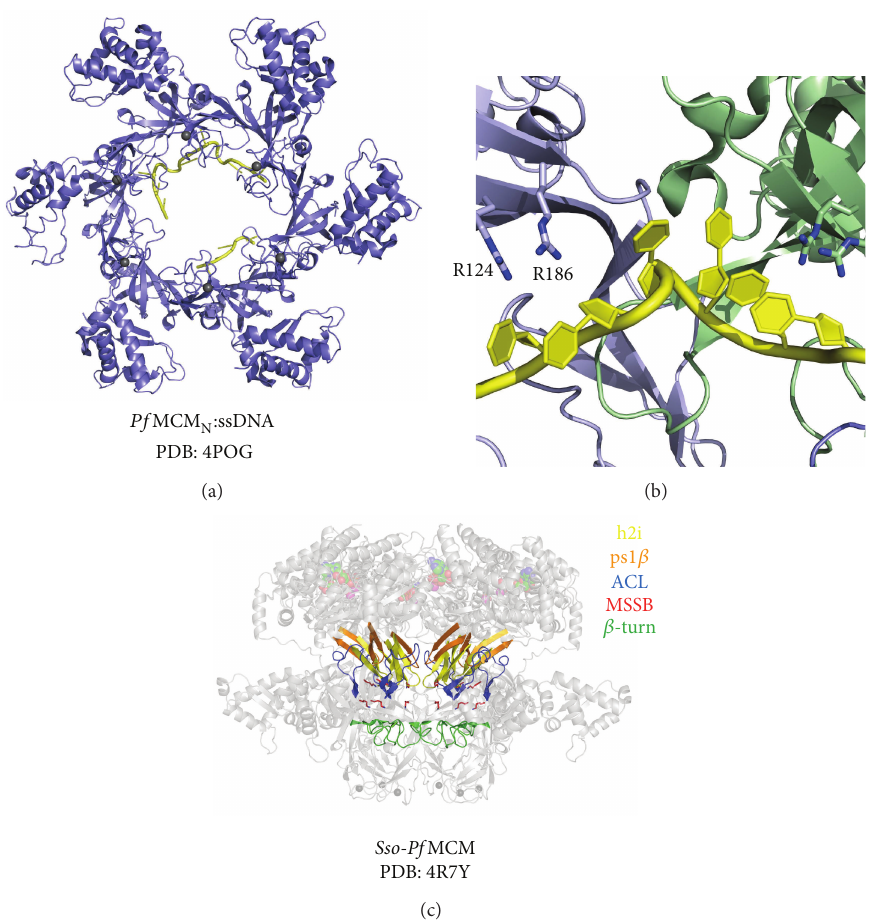
Figure 6: Features of DNA binding in MCM hexamers. (a) The cocrystal structure of 𝑃𝑓 MCM in the plane of the hexamer. The DNA binds with a 3 󸀠 to 5 󸀠 polarity in the clockwise direction around the ring when viewed from the N- terminal side of the hexamer. DNA is shown in yellow and zinc ions are shown as grey spheres. (b) DNA binds across subunit interfaces through interactions between the DNA and MCM Single-Strand Binding (MSSB) residues R186 and R124 ( 𝑃𝑓 MCM 4POG), shown in stick. (c) Important residues of the central channel in the MCM hexamer structure (PDB: 4R7Y) with other components transparent. The h2i, ps1 𝛽 , ACL, MSSB, and N-terminal 𝛽 -turn motifs are shown in yellow, orange, blue, red, and green, respectively. All structure representations of Figure 6 were prepared with the Pymol software package